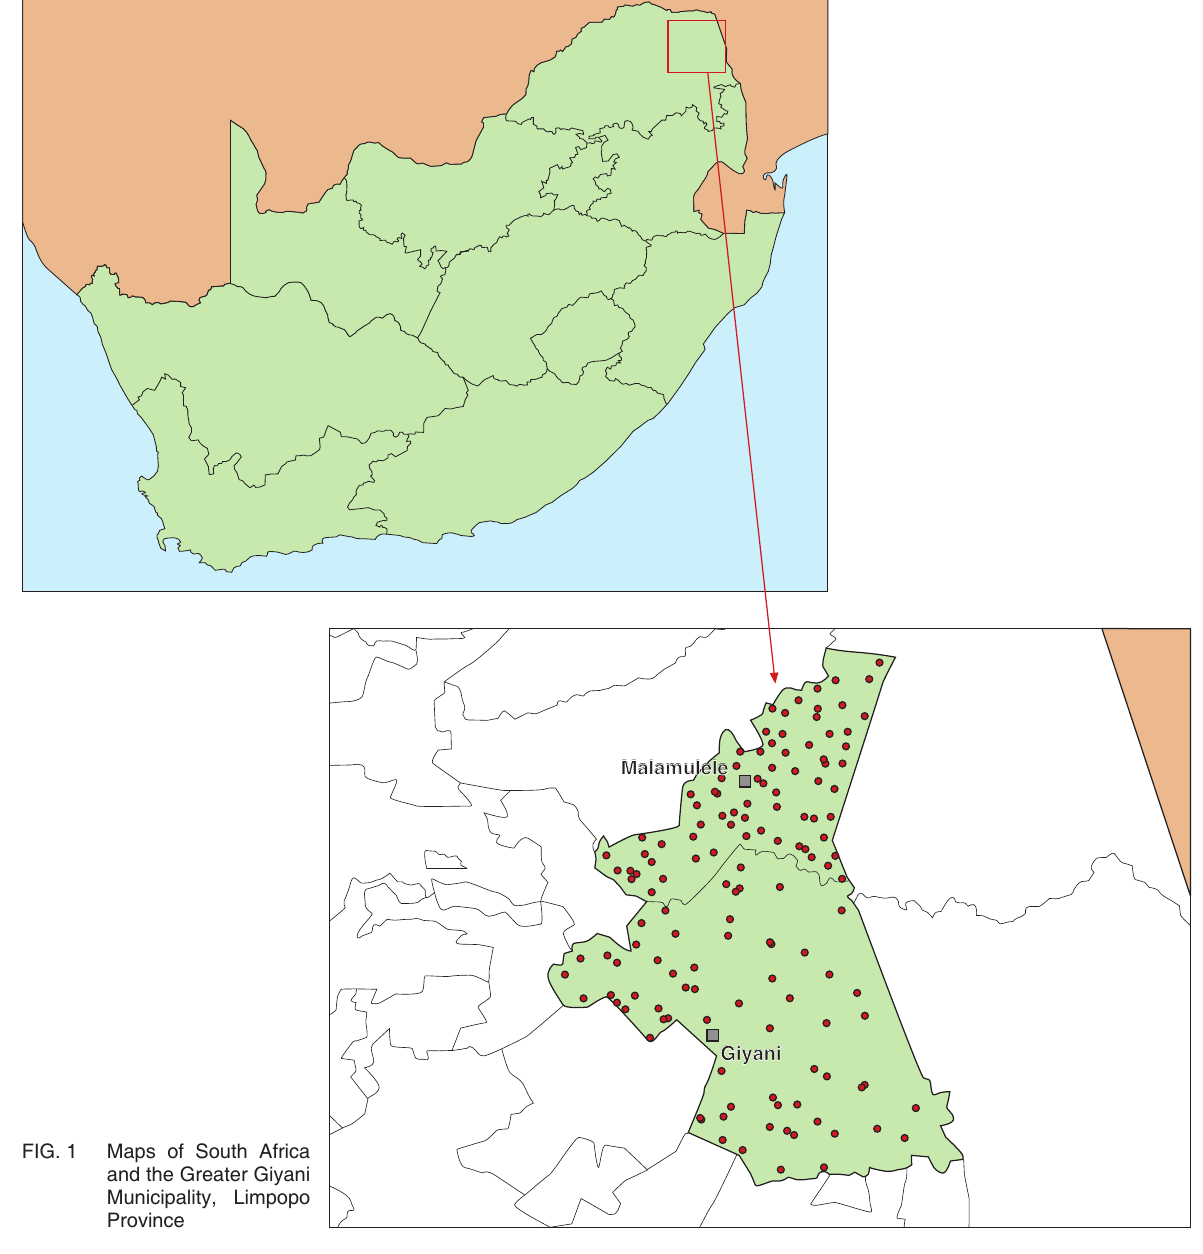
FIG. 1 Maps of South Africa and the Greater Gi yani Muni ci pal ity, Lim po po Prov